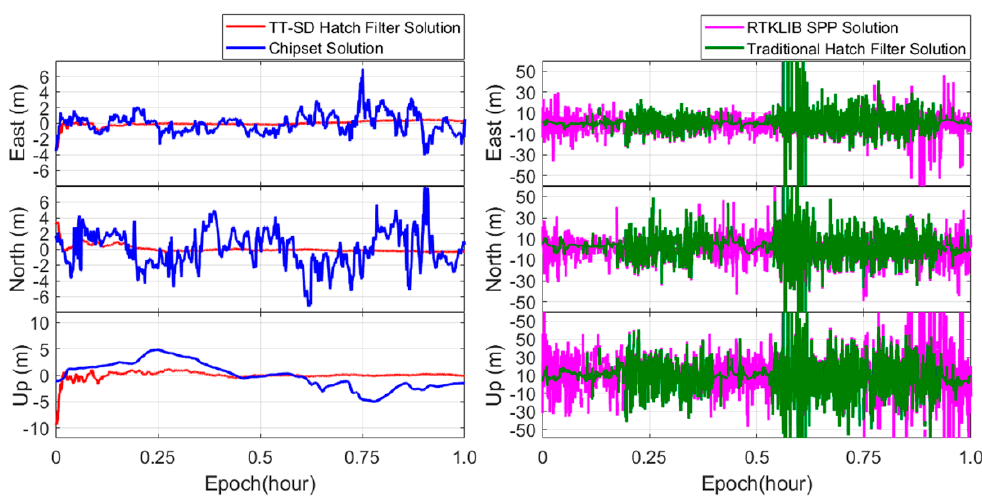
Figure 8. Comparison of the static single point positioning performance. In the left panel, the red and blue lines represent the TT-SD Hatch-filter (Three-Thresholds and Single-Difference Hatch filter) positioning errors and the GNSS chipsets positioning errors of Nexus 9 respectively. In the right panel, the pink and green lines represent the RTKLIB SPP (Single Point Positioning) errors and the traditional Hatch filter with 600s-window positioning errors of Nexus 9, respectively.